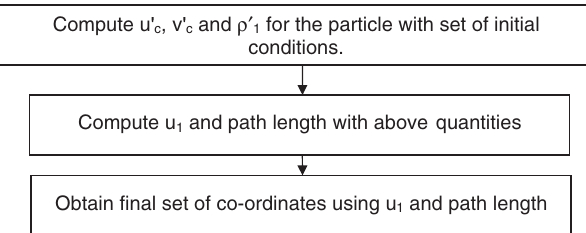
FIG. 3. Steps for computing final coordinates of the particles from initial coordinates using analytical expression.